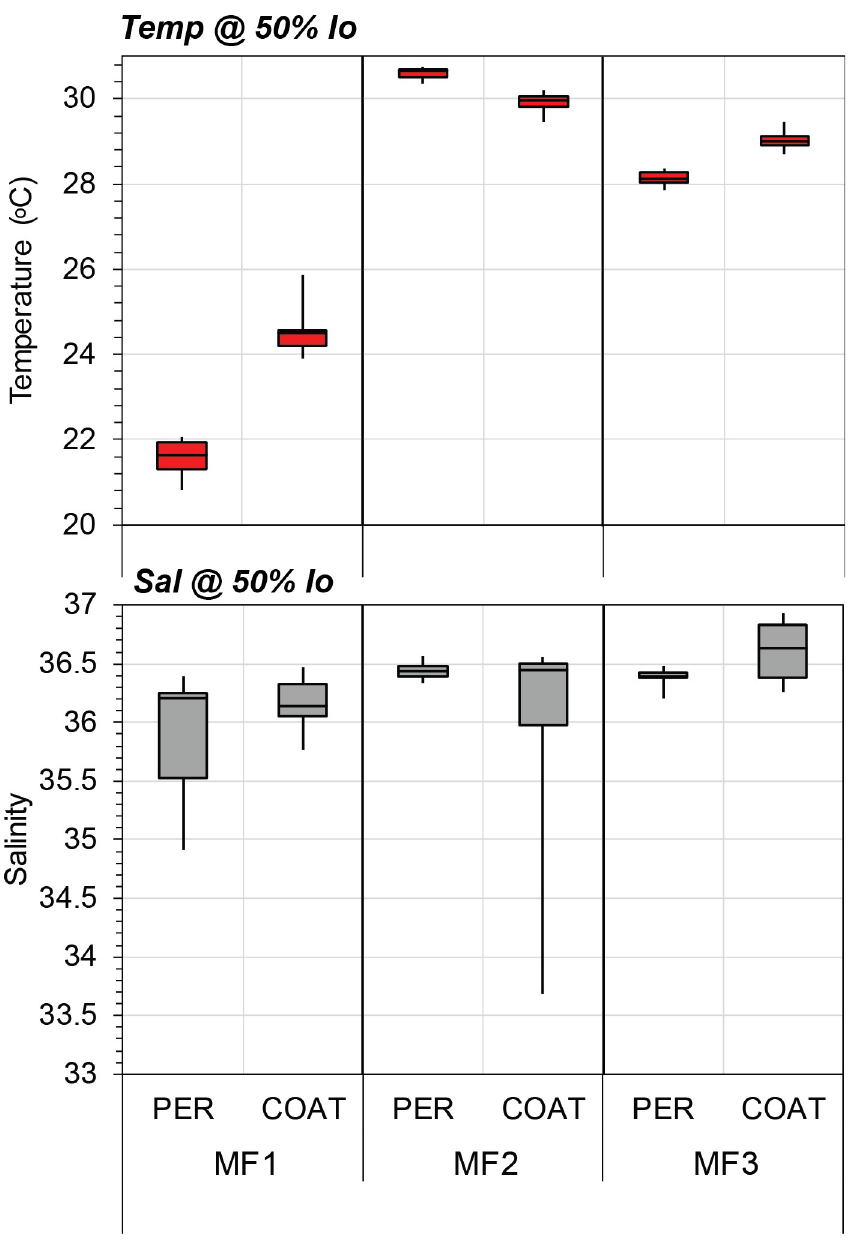
Fig 9. Temperature (˚C) and salinity per cruise in the upper euphotic zone. Median values of temperature (˚C; upper panel) and salinity (lower panel) from data recorded between 11–17 m depth (~50% surface irradiance, %Io) at the Perdido (PER) and Coatzacoalcos (COAT) regions during MF1 (late winter 2016), MF2 (late summer 2016), and MF3 (spring 2018) cruises. For each hydrographic variable, the rectangular box represents the middle 50% of the data, delimited by the lower quartile (Q1) and upper quartile (Q3). The median is represented by a straight line inside the box. Whiskers are drawn for the minimum and maximum